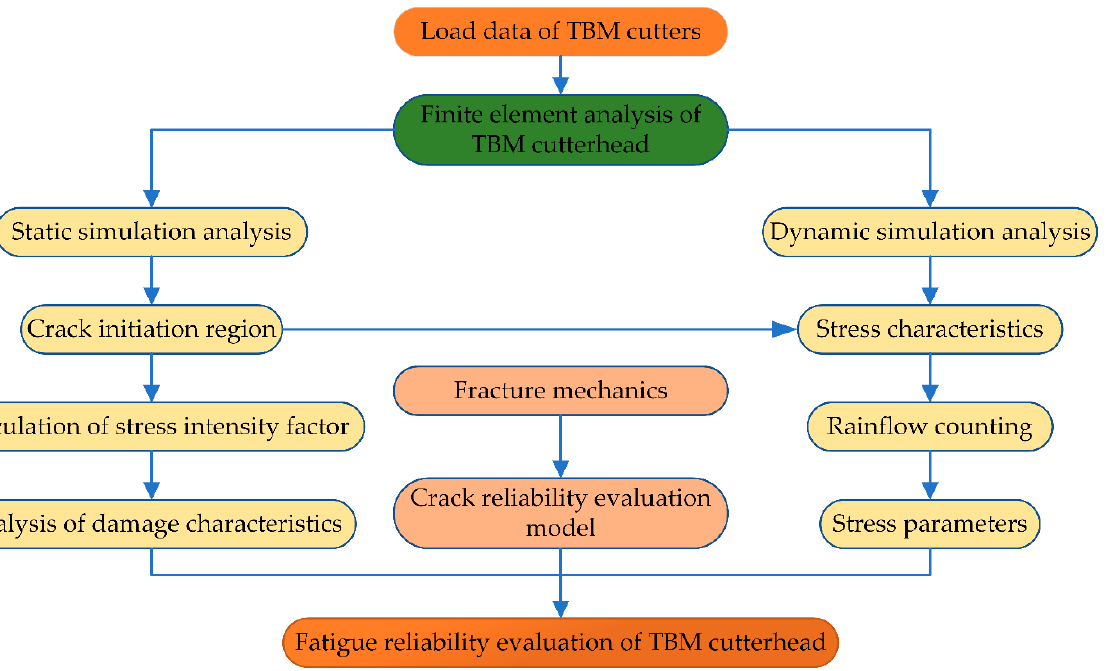
Figure 1. The overall flowchart. TBM: tunnel-boring machine.